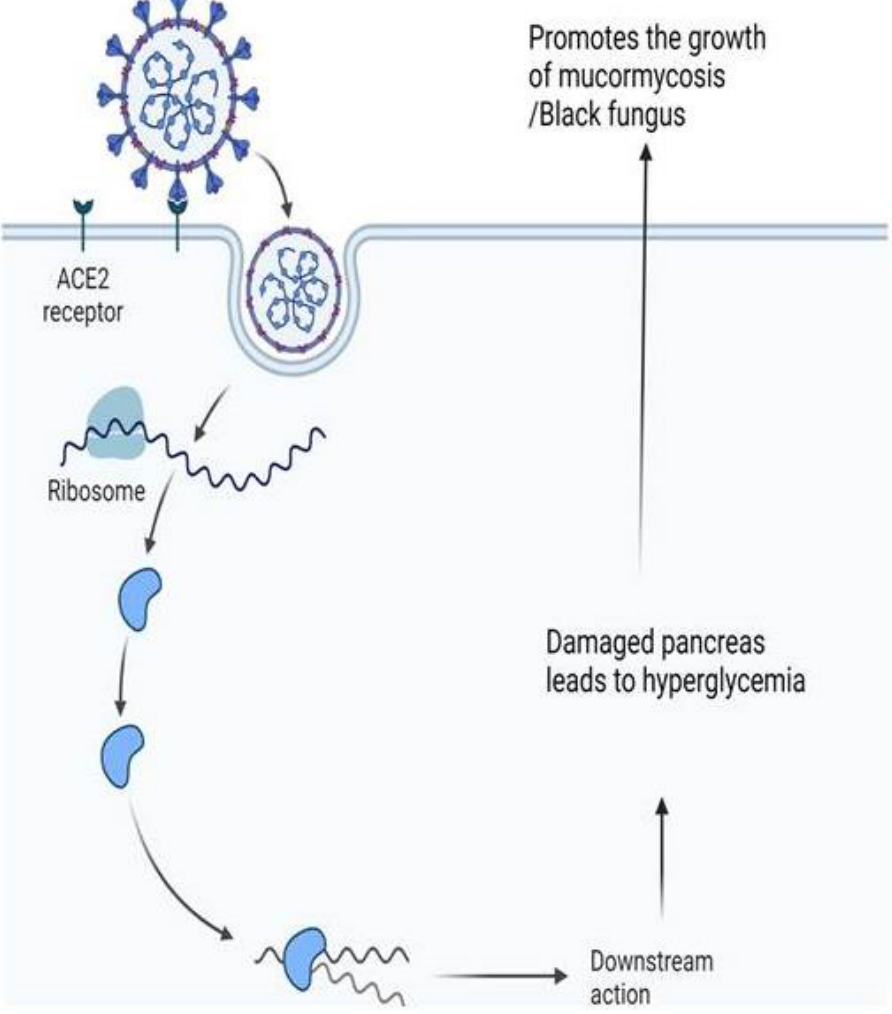
Figure 3. Diabetic condition promotes the growth of mucormycosis in COVID-19 patients by inducing damage to the pancreas. SARS-CoV-2 enters the human body via spike protein available on the envelope which binds with angiotensin-converting enzyme 2 (ACE 2). COVID-19-affected patients develop a dysfunction of the immune system with a decrease in lymphocyte counts and an exponential rise in inflammation. Treatment of COVID-19 patients with immunosuppressant having uncontrolled diabetes mellitus and ketoacidosis are also at major risk for Mucormycosis as it leads to dysfunctional phagocytes causing impaired intracellular killing by oxidative and non-oxidative mechanisms.